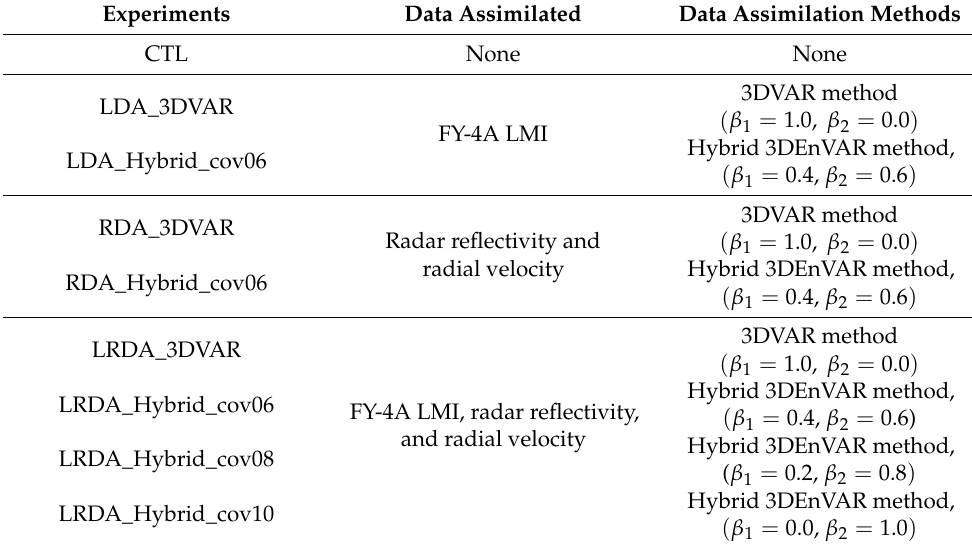
Table 1. Abbreviations used for the experiments and descriptions of the experiments. All assimila- tion experiments were performed using single and cycling analysis, respectively. Single-analysis experiments were at 0000 UTC on 30 June, and cycling analysis experiments were performed from 0000 to 0100 UTC on 30 June with 15 min frequency. In single-analysis experiments, lightning fre- quency was accumulated from 2300 UTC on 29 June to 0030 UTC on 30 June, and in cycling analysis experiments, lightning frequency was accumulated for the 15 minutes before the analysis moment. To test the different hybrid coefficients, two sets of hybrid coefficients were used to assimilate the combined lightning and radar data. The label “cov06” represents β 1 = 0.4 and β 2 = 0.6, label “cov08” represents β 1 = 0.2 and β 2 = 0.8, and the label “cov10” represents β 1 = 0.0 and β 2 =